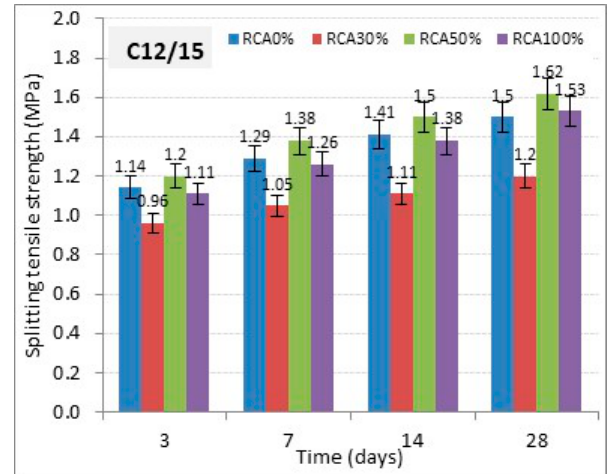
Figure 11. Effect of RCA content on the splitting tensile strength development for C12/15 concretes. Figure 11. E ff ect of RCA content on the splitting tensile strength development for C12 / 15 concretes. Buildings 2020 , 10 , x FOR PEER REVIEW